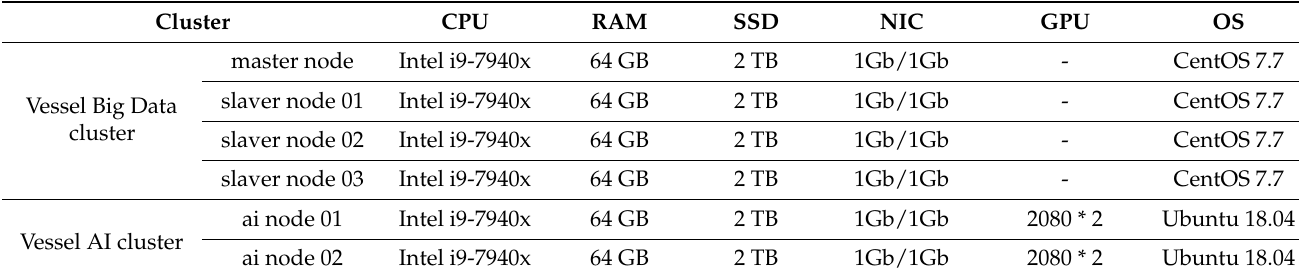
Figure 2. Conceptual Diagram of Hadoop-based Vessel Data Lake (Software stack). Table 2. Hardware Specifications of Vessel Data